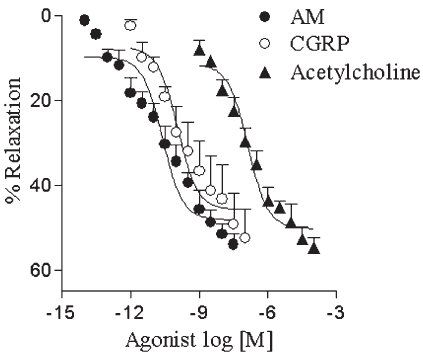
Figure 3. Concentration-response curves for AM, CGRP, and acetylcholine obtained in isolated rat cavernosal smooth muscle strips. The curves were obtained in CSM pre-contracted with phenylephrine (10 m M). Data are reported as means±SE of 5 to 6 independent preparations. AM: adrenomedullin; CGRP: calci- tonin gene-related